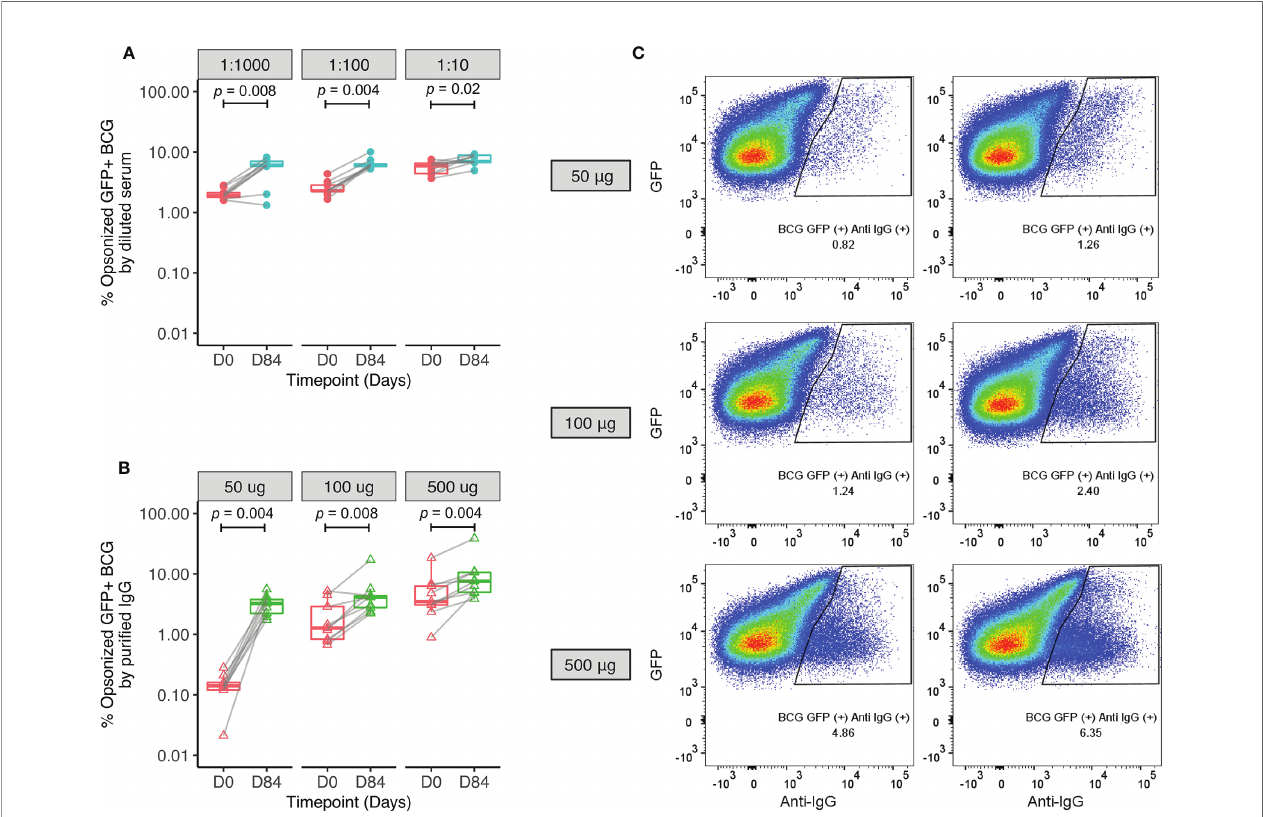
FIGURE 5 | Enhanced opsonization of BCG-GFP with sera or puri fi ed IgG following BCG vaccination. Samples were used from n=9 healthy UK adults enrolled into human Study 1. BCG-GFP was incubated with either serum at different dilutions (A) or puri fi ed IgG at different concentrations (B) collected at baseline and 84 days post-BCG vaccination, and the percentage of BCG-GFP that was opsonized was determined by fl ow cytometry. Points represent the mean of duplicate values, boxes indicate the median value with the interquartile range (IQR) and the upper whisker extends to the largest value no further than 1.5 * IQR from the hinge, the lower whisker extends from the hinge to the smallest value at most 1.5 * IQR from the hinge. Outliers are plotted individually. A Wilcoxon matched-pairs test was used to compare between time-points. Flow plots are shown from a single replicate of one subject at baseline and 84 days post-BCG vaccination using different concentrations of puri fi ed IgG (C)